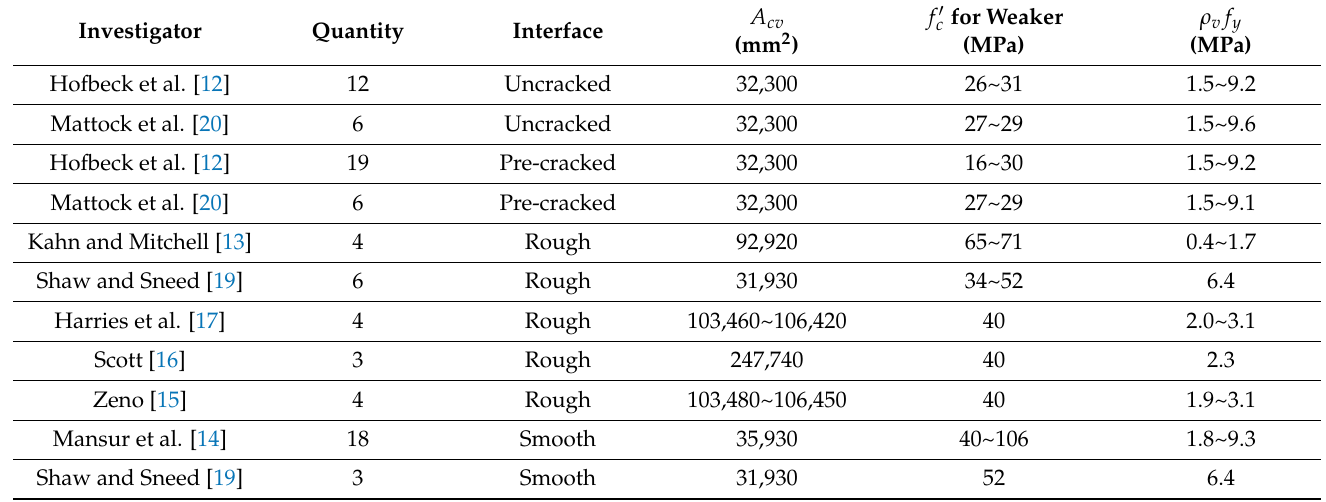
Table 3. List from experimental database by push-off